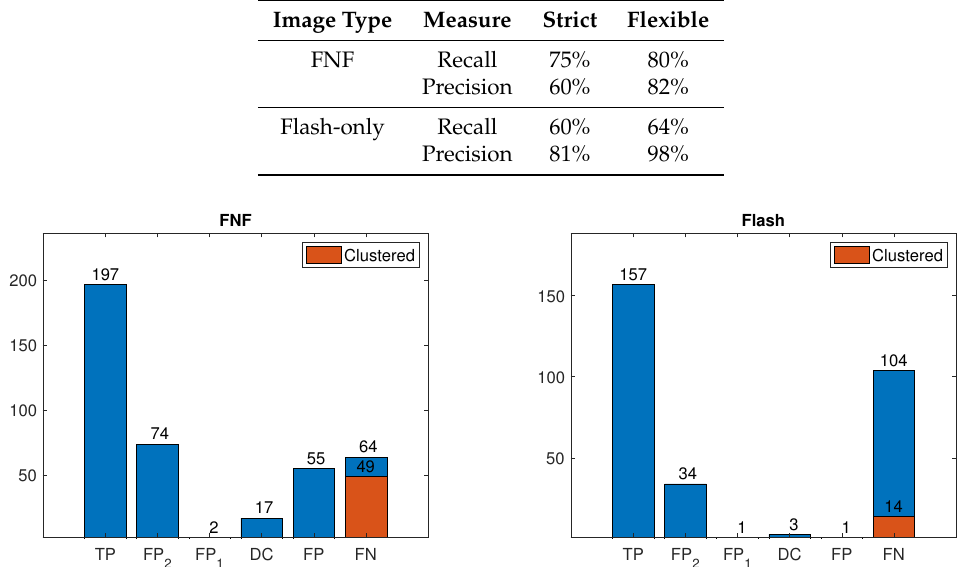
Table 3. Performance evaluation of the color-based algorithm across the entire data-set.